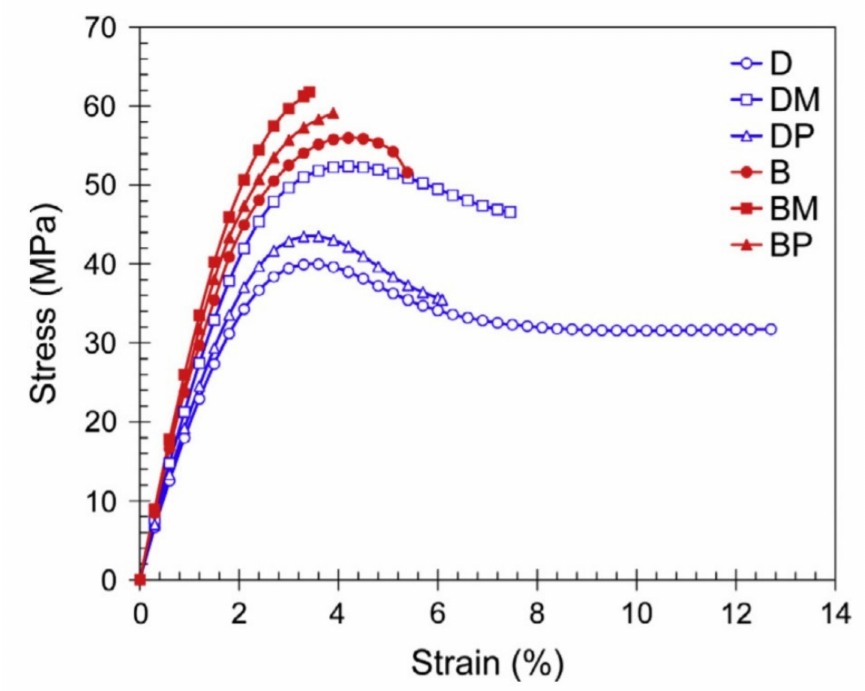
Figure 9. Tensile strain–stress curve of pure epoxies and their corresponding CNT reinforced com- posites. D: ductile epoxy, B: brittle epoxy, P: CNT powder and M: CNT masterbatch. The tensile test results are the mean of three experiments with a standard deviation around ± 2%. [111]; used with permission from Composites: Part A, Elsevier,